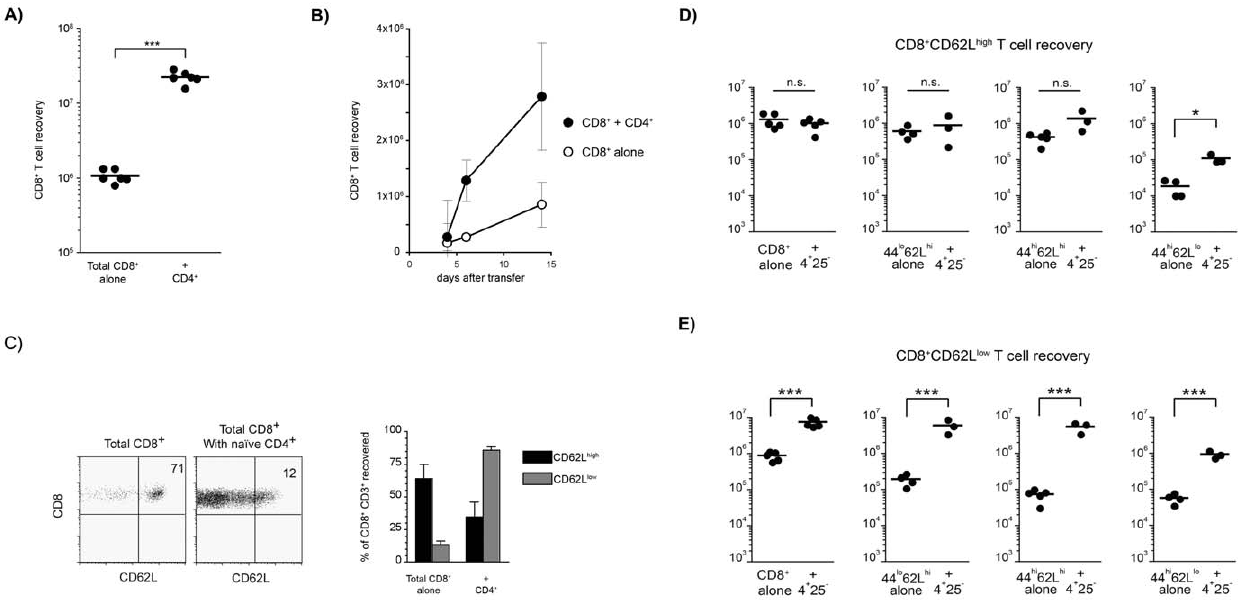
Figure 1. CD4 + T cells modify the LDP of CD8 + T cells. ( A ) 2 6 10 4 CD8 + T cells were transferred alone or co-transferred with 2 6 10 4 CD4 naive T cells into CD3 e 2 / 2 lymphopenic mice. The data represent the absolute numbers of CD8 + T cells recovered 8 weeks after transfer in each group of mice with each dot representing recovery in an individual host and the bar indicating the mean values in each group. The presence of CD4 + T cells significantly increased CD8 + T cell recoveries (*** p , 0.001). Similar findings were obtained in 5–6 independent experiments. ( B ) The number of CD8 + T cells recovered at 4, 6 and 14 days after when transferred (alone, open dots) or co-transferred with CD4 naive T cells (filled dots) into CD3 e 2 / 2 lymphopenic mice. Data represent mean 6 se. n=3 mice. Similar results were obtained in a second independent experiment. ( C ) Dot plots showing the CD62L phenotype of CD8 + T cells recovered 10 weeks after the transfer of 2 6 10 4 CD8 + T cells alone (left) or with 2 6 10 4 CD4 naive T cells (right) into lymphopenic mice. Each dot plot shows a representative staining and values inside the dot plot are the % in the respective quadrant. The right hand graph shows the relative representation of the CD62L high and CD62L low cells (mean 6 se) among the CD8 + T cells recovered when transferred alone or in the presence of CD4 + T cells. Similar results were obtained in 5–6 independent experiments. ( D ) Absolute numbers of CD62L high CD8 + T CM cells recovered 10 weeks after the injection of 2 6 10 4 total CD8 + T cell from different subpopulations transferred alone or with 2 6 10 4 CD4 + T cells into CD3 e 2 / 2 hosts. ( E ) Absolute numbers of CD62L low CD8 + T EM cells recovered 10 weeks after the injection of 2 6 10 4 of different CD8 + T cell from different subpopulations transferred alone or with 2 6 10 4 CD4 + T cells into CD3 e 2 / 2 hosts. Statistically significant differences are shown (* p , 0.05, ** p , 0.01, *** p , 0.001). In all cases CD8 + T EM cell numbers increased 10-fold or more in presence of CD4 help. Please note that recovery of CD62L high cells after the transfer of CD62L low CD8 + cells in presence of CD4 help was increased, but this recovery was 10-fold lower (10 5 cells) than the recovery of the CD8 + T EM cells.